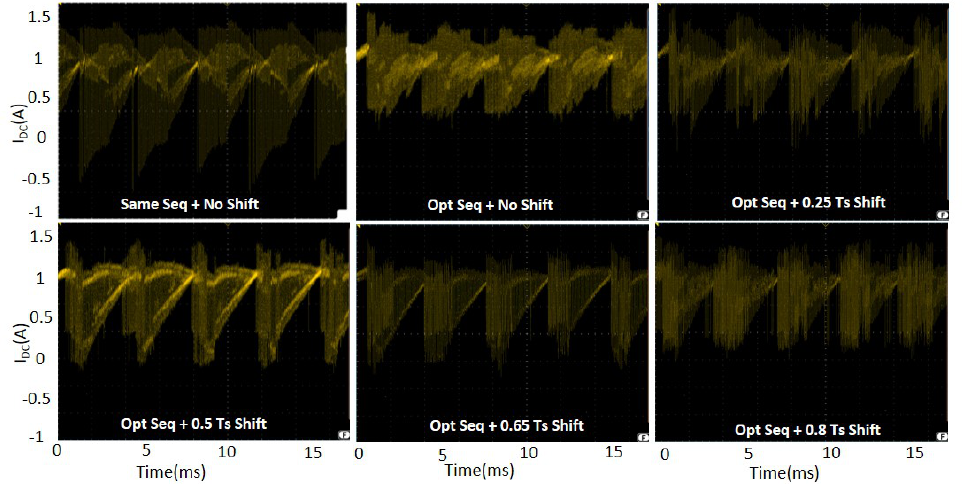
Figure 18. Experimental DC − link current for sequence+time-shifted interleaving at 20 ◦ pf